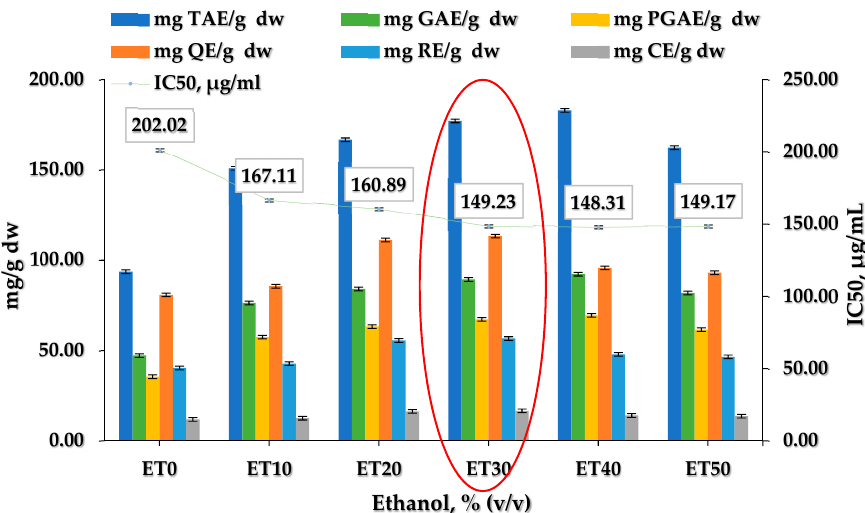
Figure 1. Effect of the solvent concentration on the extraction of Cistus incanus leaves, stalks, and buds at the 80th min on Total polyphenol content (TPC), Total flavanoid content (TFC), and Inhibition capacity at 50 % (IC 50 ).